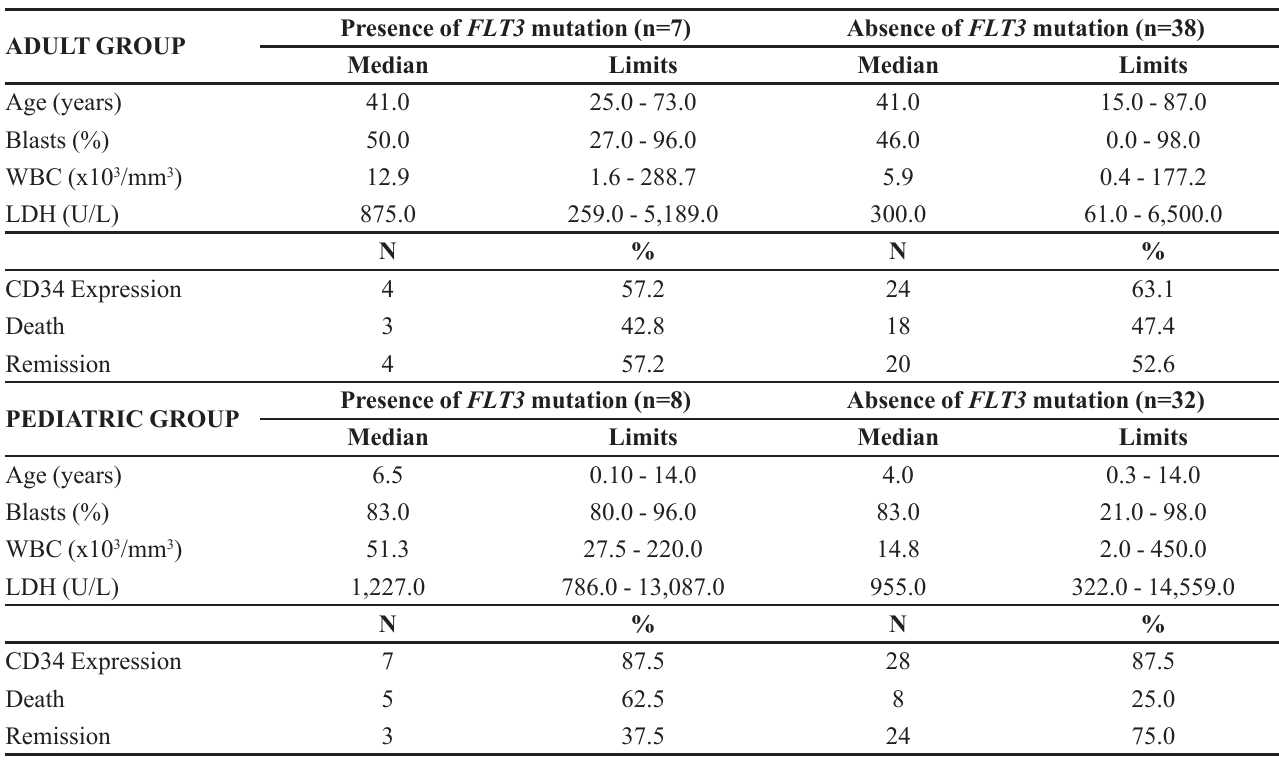
TABLE II - Values of age, percentage of blasts, WBC count, LDH activity, CD34 expression, and progression of patients with AL according to the absence or presence of FLT3 mutation and group ADULT